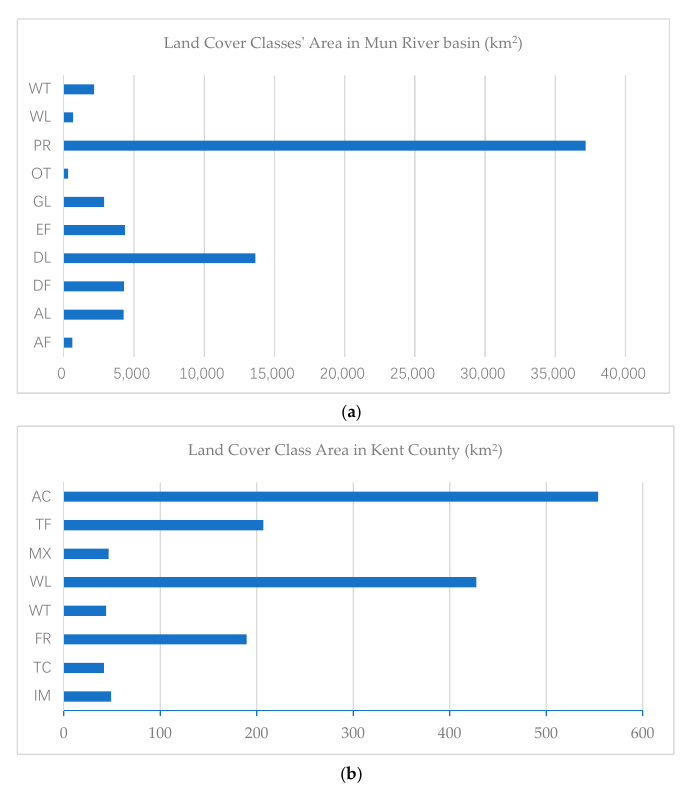
Figure 19. Area of land cover classes in the Mun River Basin ( a ) and Kent County ( b ). The area distribution of classes in the Mun River Basin is imbalanced compared with Kent County.